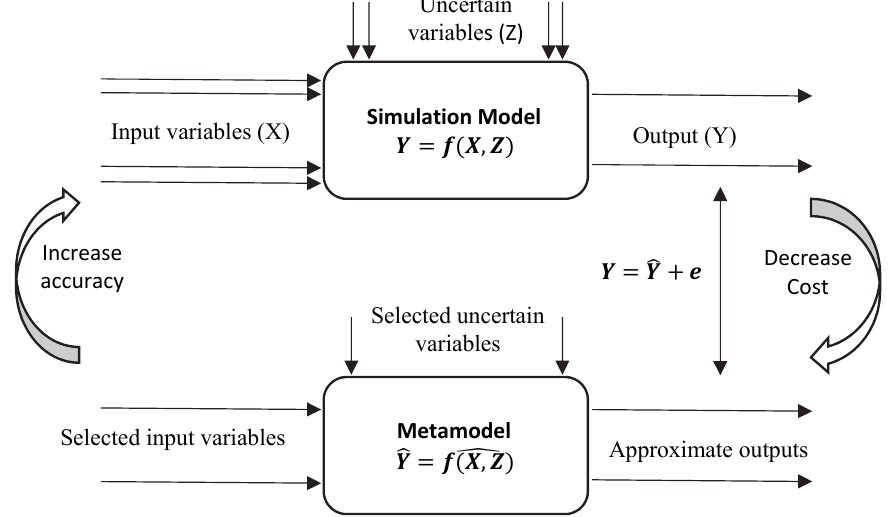
Fig. 10. The viewpoint of metamodel under uncertainty (noise variables) and relationship with a simulation